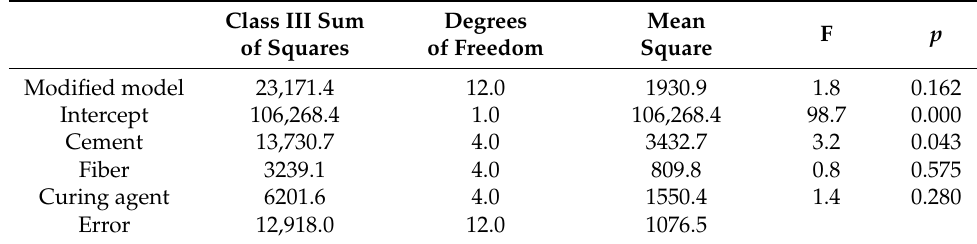
Table 6. Results of variance analysis of the cohesion.